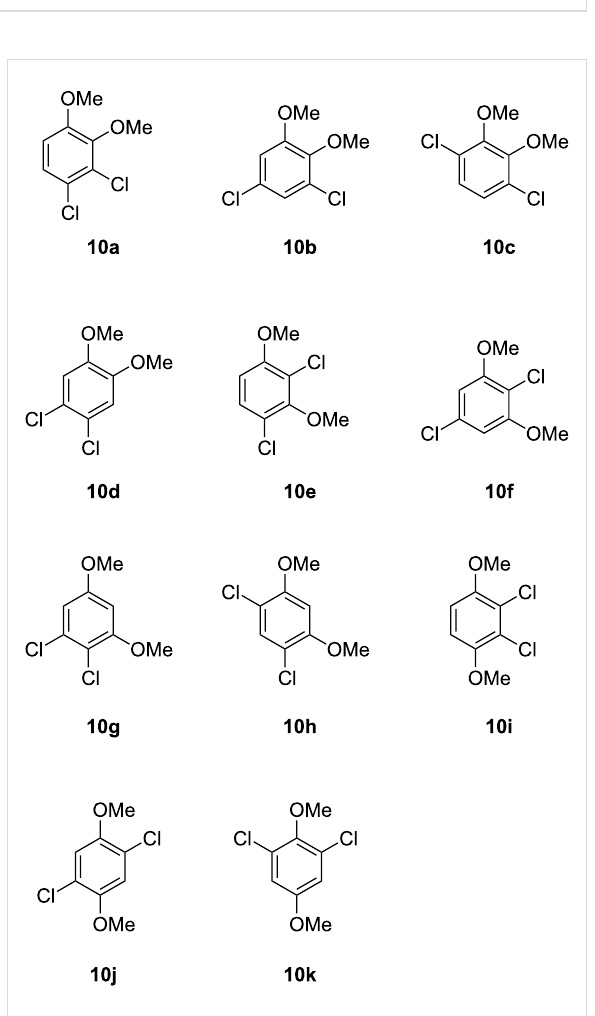
Figure 4: Constitutional isomers of dichlorodimethoxybenzene as candidate structures for Y